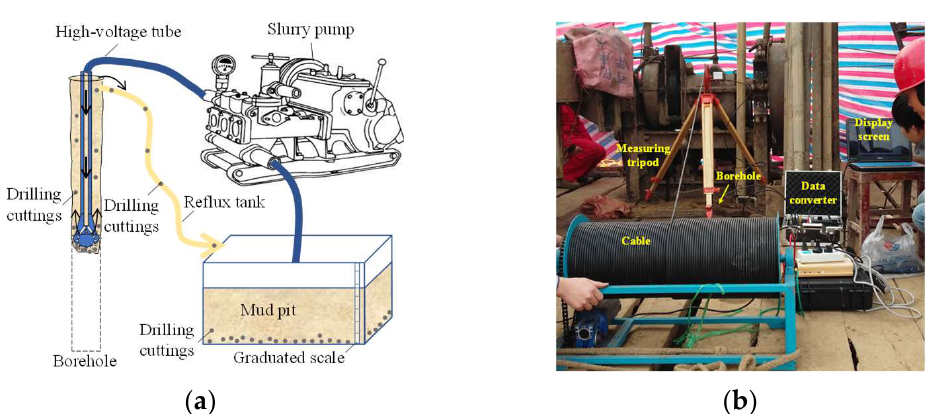
Figure 3. Method for detecting crack in borehole. ( a ) Method for monitoring drilling fluid loss and ( b ) camera system for peephole.